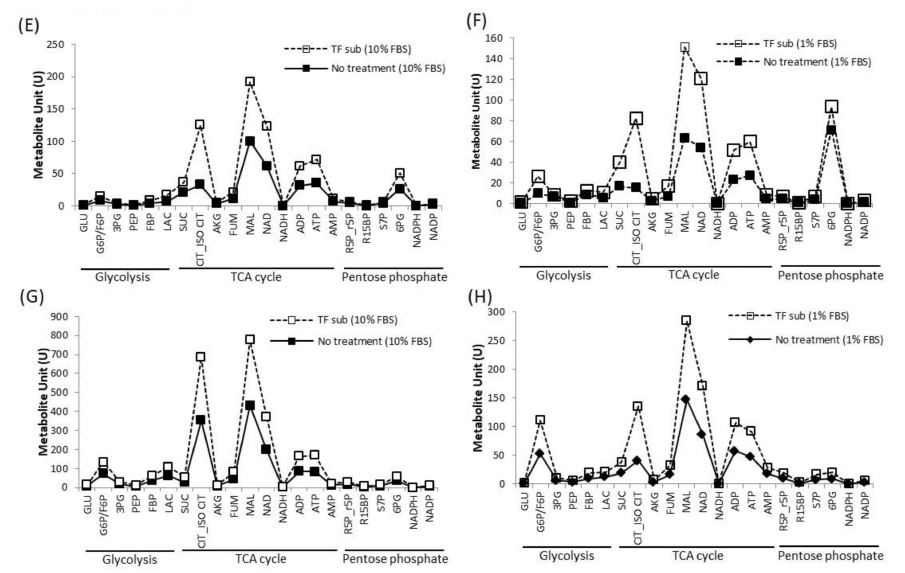
Figure 4. Regulation of oncological function by Tepidimonas fonticaldi (TF) in pancreatic cancer cells: ( A ) proliferation of cancer cells in the presence of the supernatant of TF ( n = 5, mean ± SD, * p < 0.05), ( B ) wound healing assay of SW1990 cells in the presence of the supernatant of TF ( n = 5, mean ± SD, ** p < 0.005, and * p < 0.05), ( C ) wound healing assay of Panc10.05 cells in the presence of the supernatant of TF ( n = 5, mean ± SD, ** p < 0.005, and *** p < 0.001), ( D ) alterations in transcription factors associated with epithelial-mesenchymal transition (EMT) in Panc10.05 cells in the presence of the supernatant of TF ( n = 4, mean ± SD, ** p < 0.005, *** p < 0.001), ( E , F ) alterations in cancer metabolites in Panc10.05 cells in the presence of the supernatant of TF, and ( G , H ) alterations in cancer metabolites in